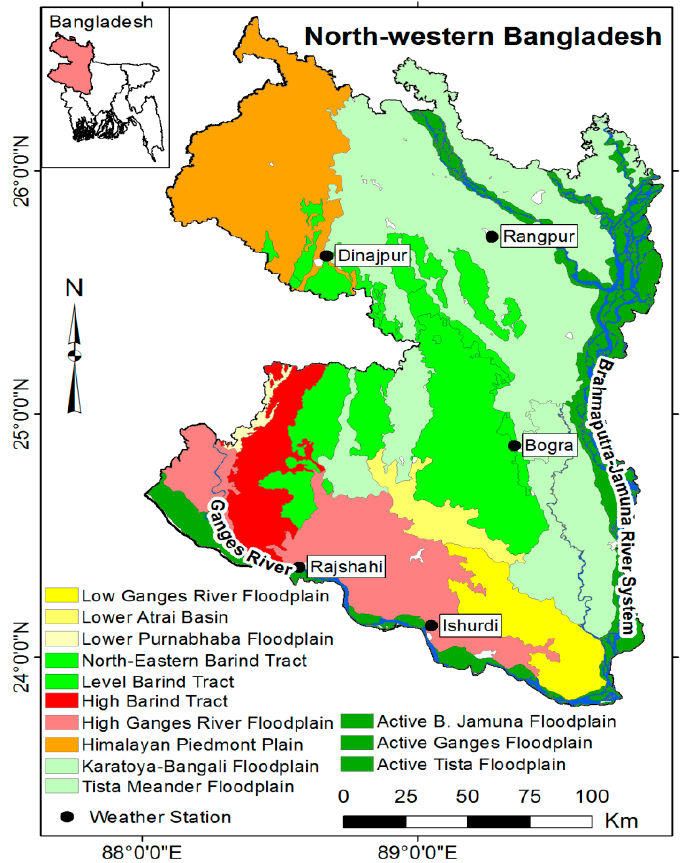
Figure 1. Study area with several major and minor physiographic units.